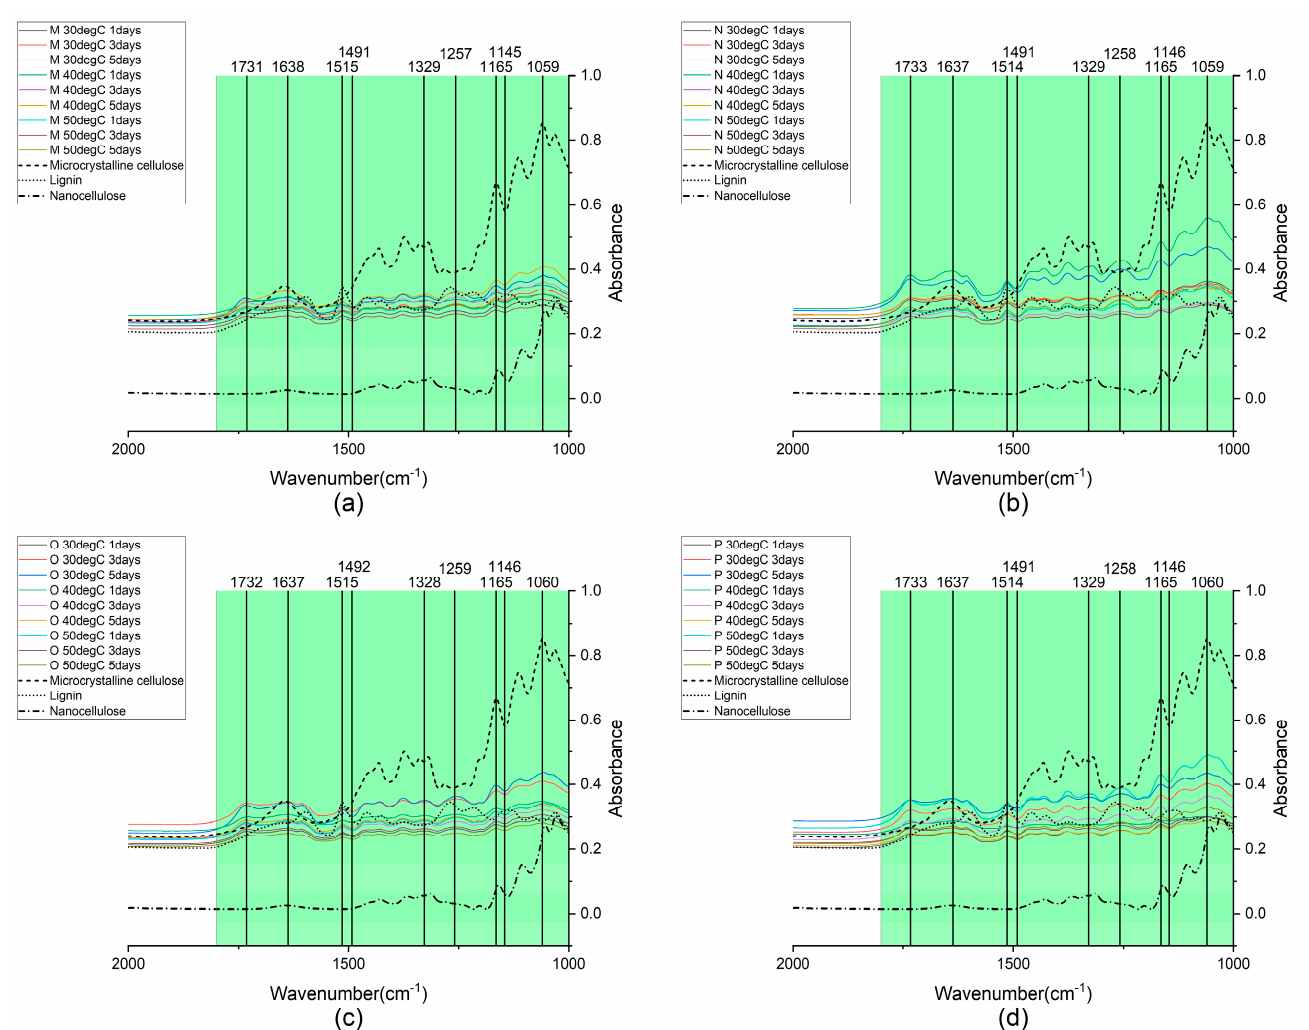
Figure 13. FTIR spectra of stem samples pretreated at 105 °C at varying incubation temperatures and times; ( a ) 15 h 250 μ m, ( b ) 15 h ball-milled, ( c ) 25 h 250 μ m, ( d ) 25 h ball-milled.